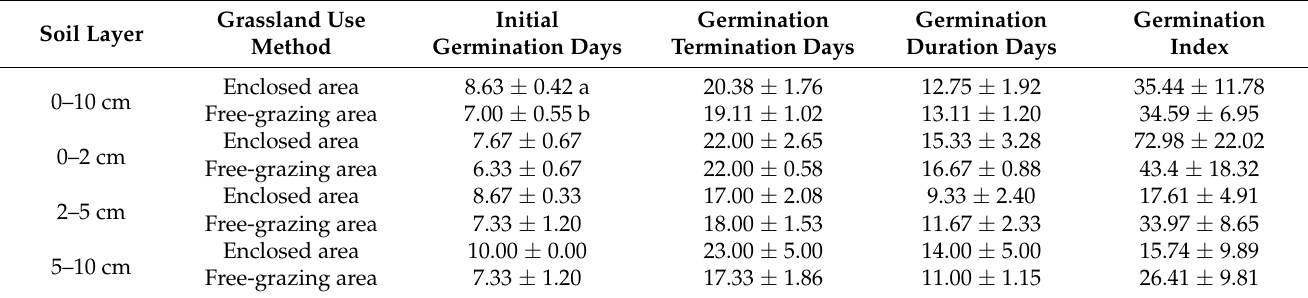
Table 2. Effects of the free-grazing and enclosed areas on the Leymus chinensis germination seed bank characteristics in the same soil layer.